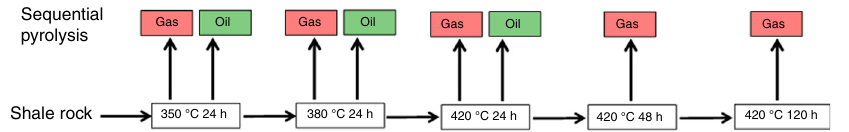
Fig. 8 Schematic diagram showing the temperatures and times used for the 5 stages in the sequential pyrolysis experiments on the Rempstone shale. The sequential experiment for Grange Hill was started at stage 3 given the initial vitrinite re fl ectance of 1.95%